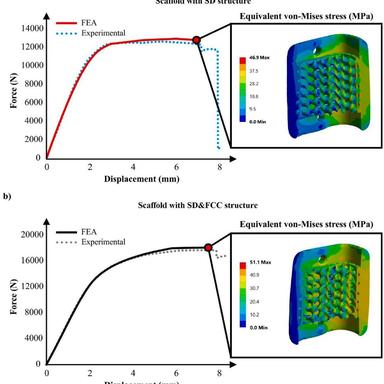
Comparison between the experimental and FEA force-displacement curves, along with the equivalent von-Mises stresses for PLA scaffolds with a) SD structure and b) SD&FCC structure.